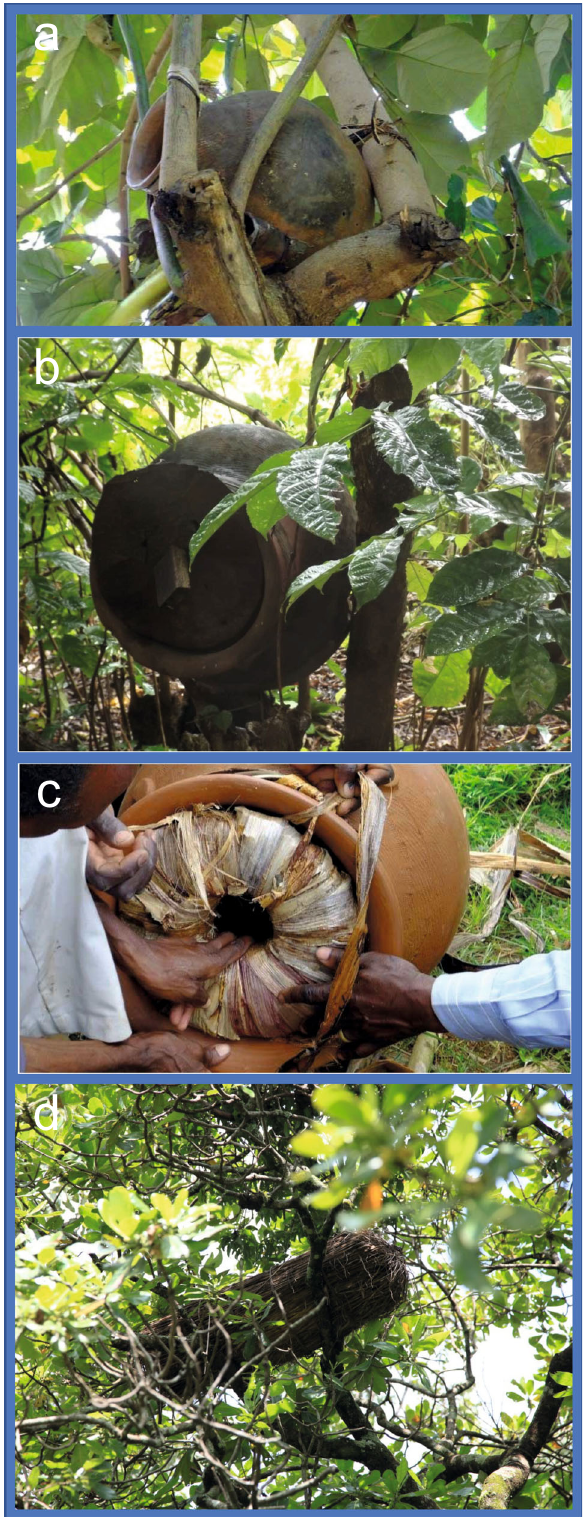
Fig. 6 Examples of modern-day African beehives. a – c Images of ceramic pots from Uganda, set in trees, being used as hives (images courtesy of Bees for Development) and d image of straw hive in a tree in